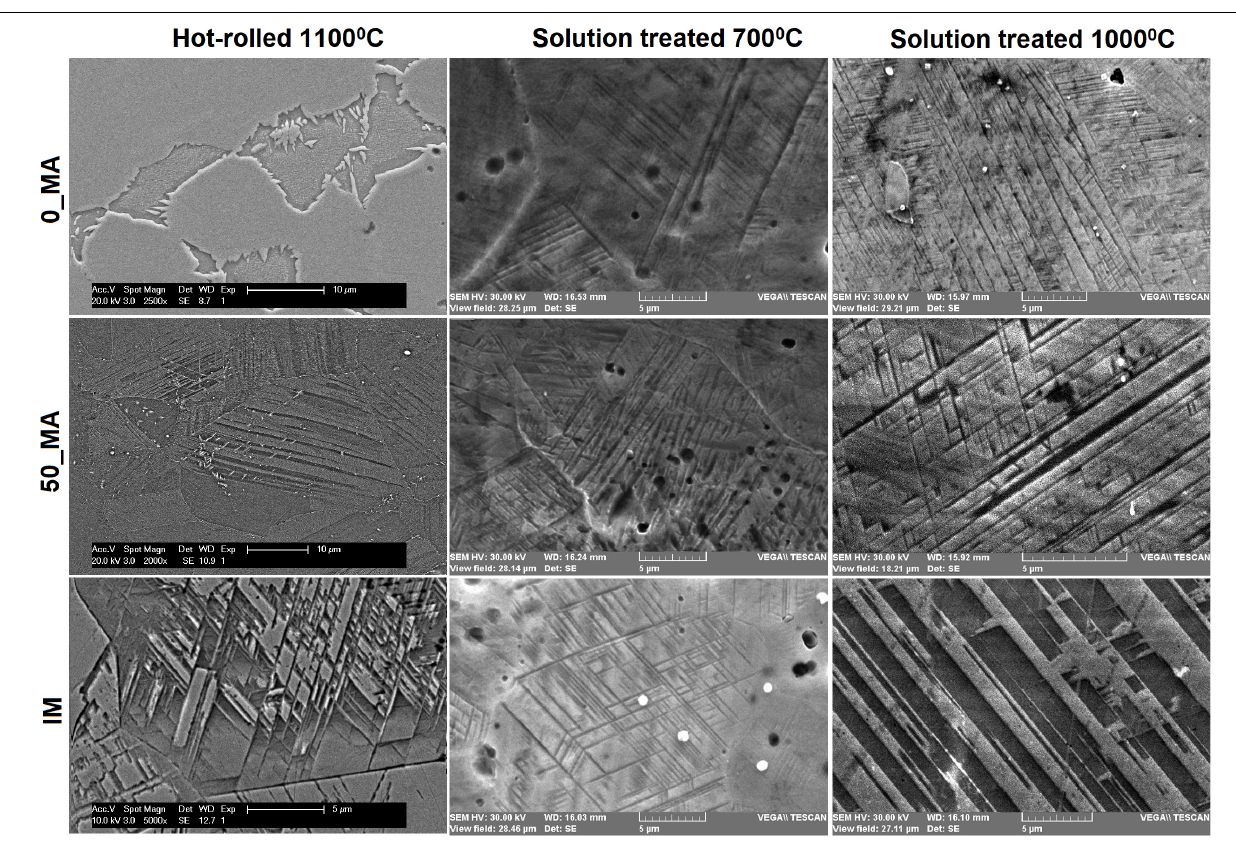
forms: (i) as-blended (0_MA) and (ii) with equal amounts of as-blended and MA’ed powders (50_MA). During each